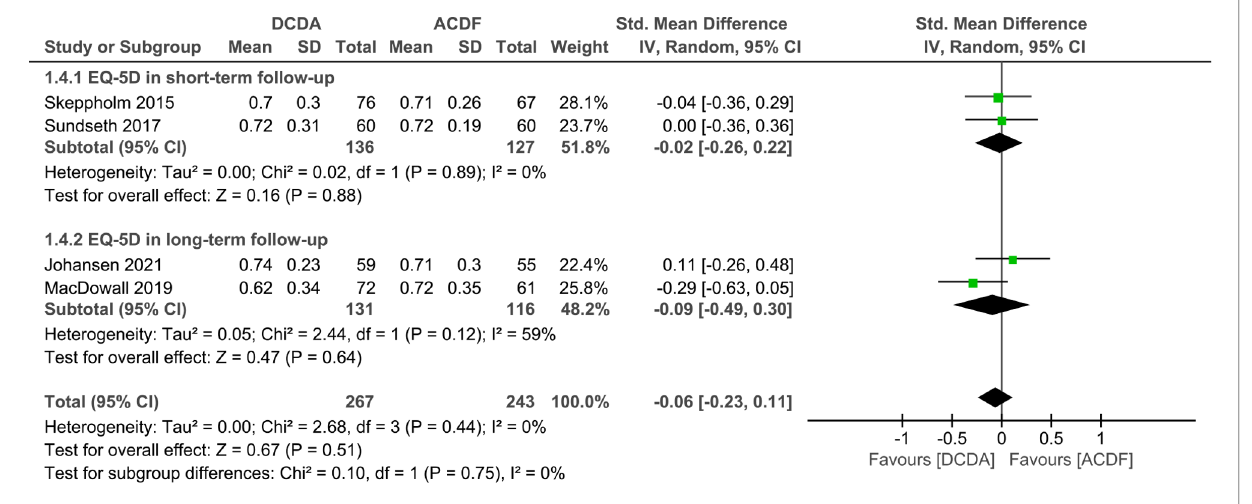
FIGURE 6 Comparison of EQ-5D score between the discover cervical disc arthroplasty (DCDA, “ experimental ” ) group and the anterior cervical discectomy and fusion (ACDF, “ control ” ) group.